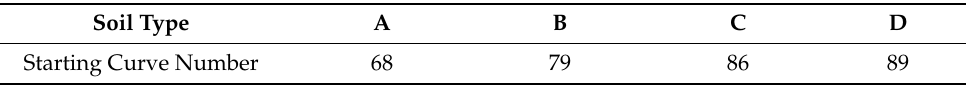
Table 1. Urban pervious curve numbers used in the Stormwater Tool to Estimate Load Reductions (swTELR) derived from United Stated Department of Agriculture (USDA, 1986)